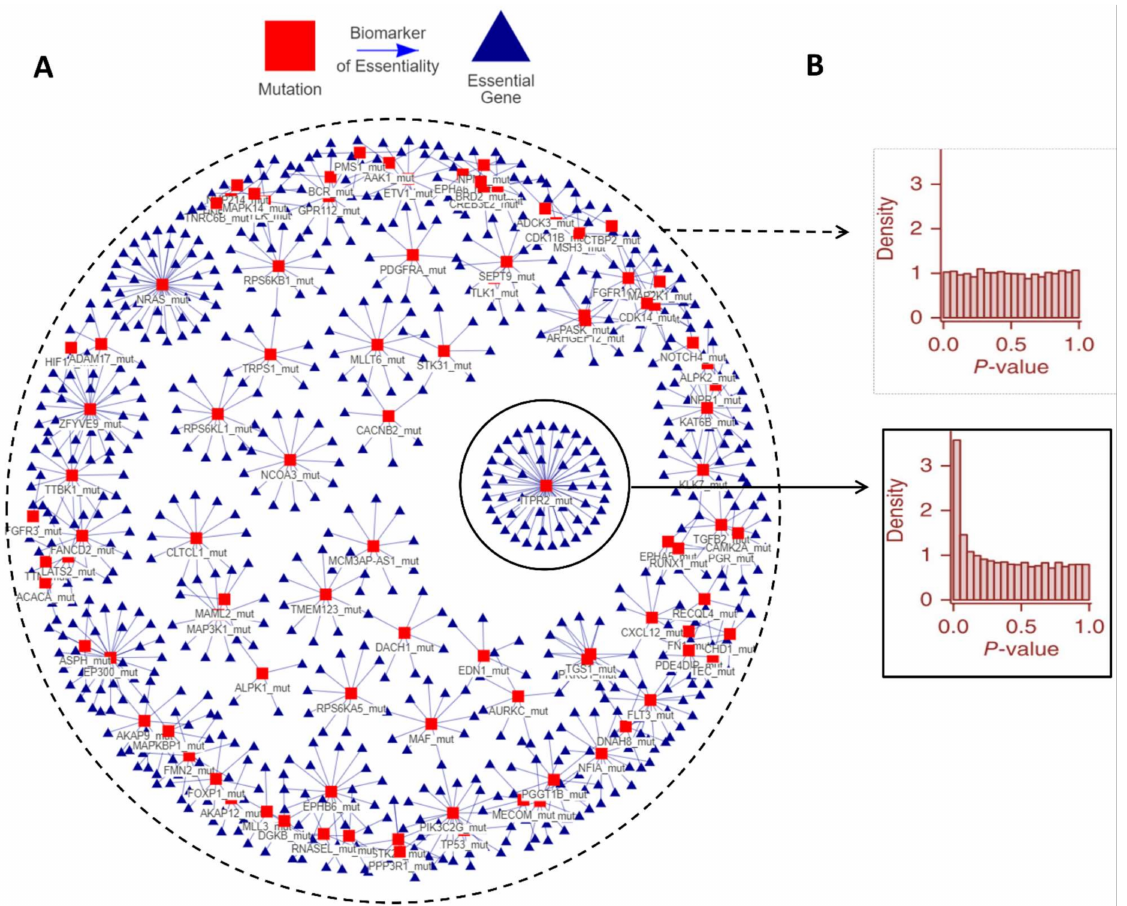
Figure 1. The hub effect in genetic essentiality in Acute Myeloid Leukemia. In each cell, a small set of gene aberrations is associated with large changes in genetic essentiality. ( A ) A bipartite graph in which red squares represent gene variants (e.g., mutations), blue triangles represent significant changes in cell viability related to knocked-down genes. Both nodes are linked by a line if the variations in the essentiality have a statistically significant association with the presence of the